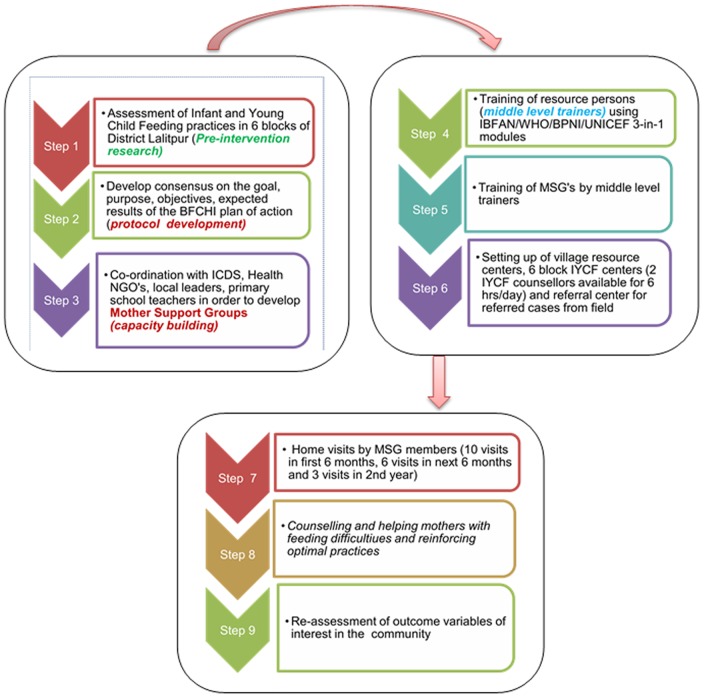
Flow diagram of project activities.MSG, Mother Support Groups; ICDS, Integrated Child Development Services; NGO's, Non-Government officials; BFCHI, Baby Friendly Community Health Initiative; IBFAN, International Baby Food Action Network; WHO, World Health Organization; BPNI, Breast feeding Promotion Network of India; UNICEF, United Nations Children's Fund; IYCF, Infant Young Child Feeding.